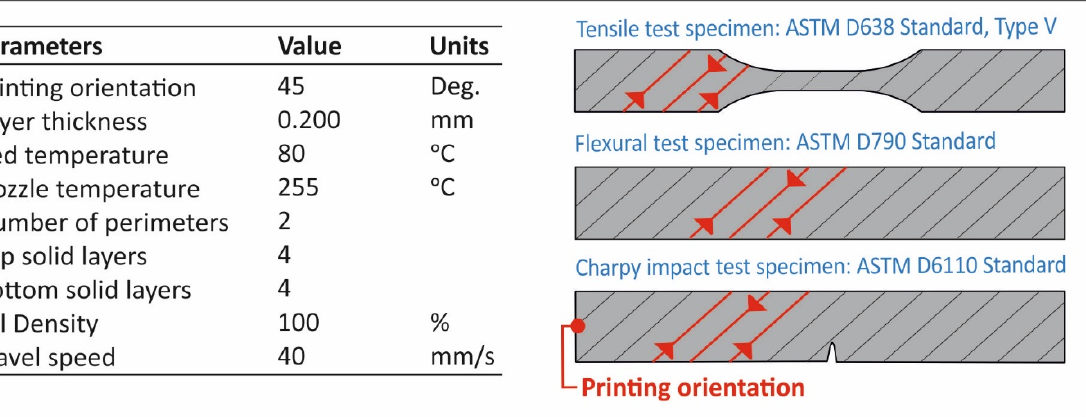
Figure 1. The optimum FFF 3D printing parameters followed in this study to manufacture the different specimens.